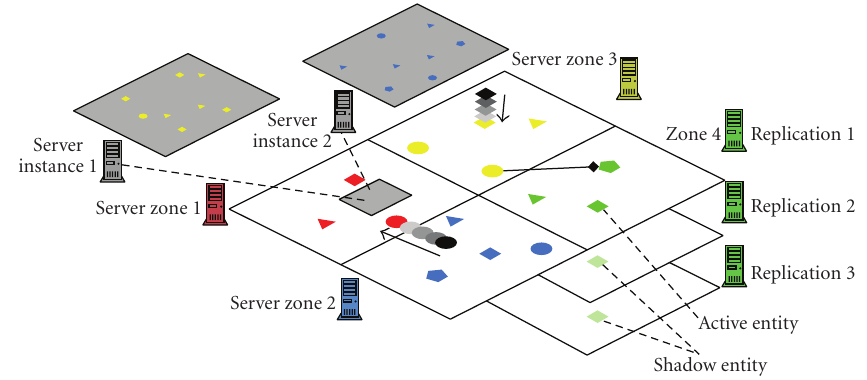
Figure 13: Combination of zoning, instancing, and replication for a single-game world in